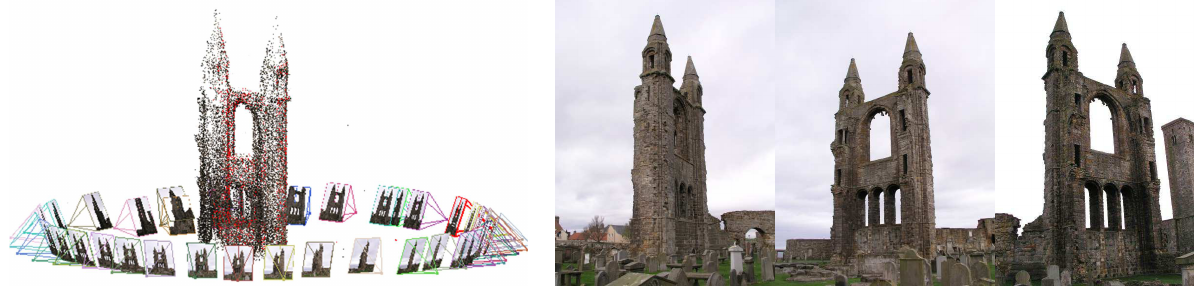
Fig. 2.1: St. Andrews dataset. 43 images with 5 Megapixels each distributed in a circle around the object.